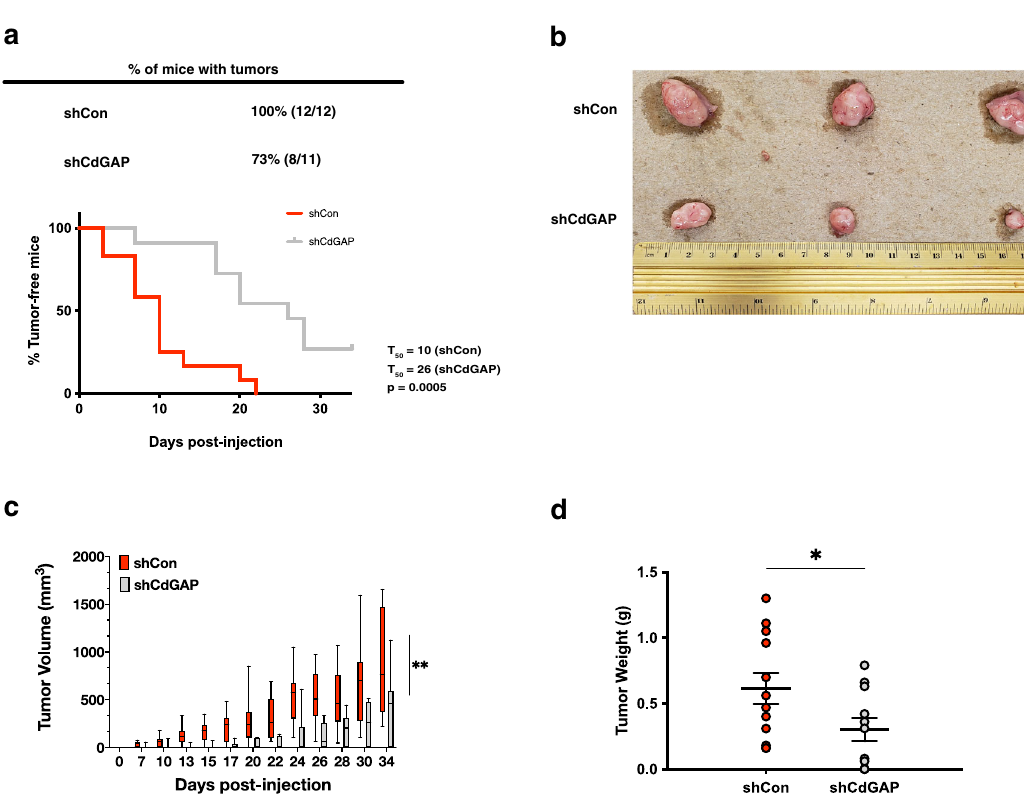
Fig. 7 Loss of CdGAP delays subcutaneous tumor formation of PC-3 cells in vivo. Control (shCon) or CdGAP-depleted (shCdGAP) PC-3 cells were injected into the right fl anks of 7-week-old nude mice. a Kaplan – Meier analysis of tumor-free mice using tumor initiation as an endpoint. Time of tumor initiation was de fi ned as when a tumor reached a volume of 20 mm 3 . b Representative photographs of endpoint tumors that formed in control ( n = 12) and shCdGAP (ndGAP) groups of mice. c Growth curves of subcutaneously formed tumors. Tumor volume was measured three times a week up to 34 days and is presented as the mean volume of each group (control = 12; shCdGAP = 11). Error bars indicate standard deviation (SD). d Tumor weight was measured at endpoint from control ( n = 12) and shCdGAP ( n = 11) groups of mice. Error bars indicate SEM. Two-sample unpaired Student ’ s t test for comparison between two groups (shCon; shCdGAP). ** p < 0.001; * p <